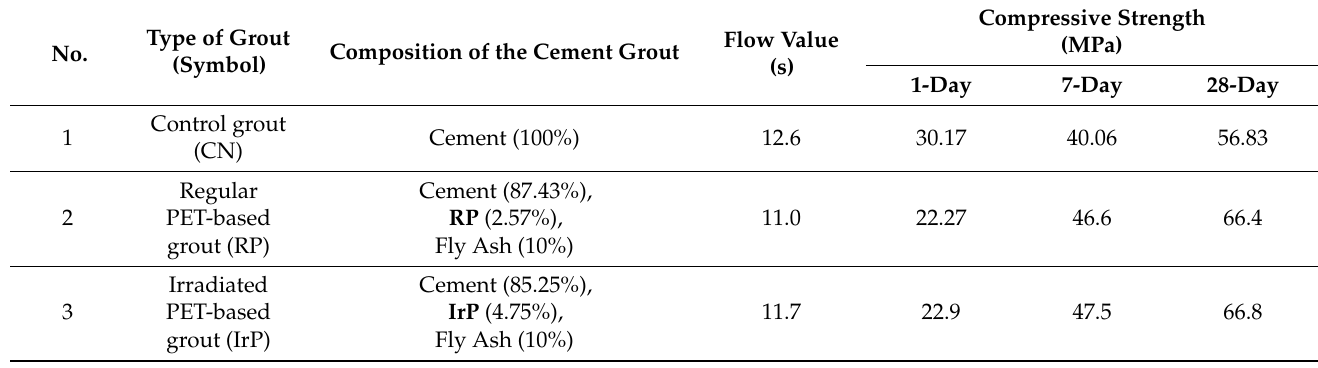
Table 1. Composition of the pre-designed grouts and their properties.